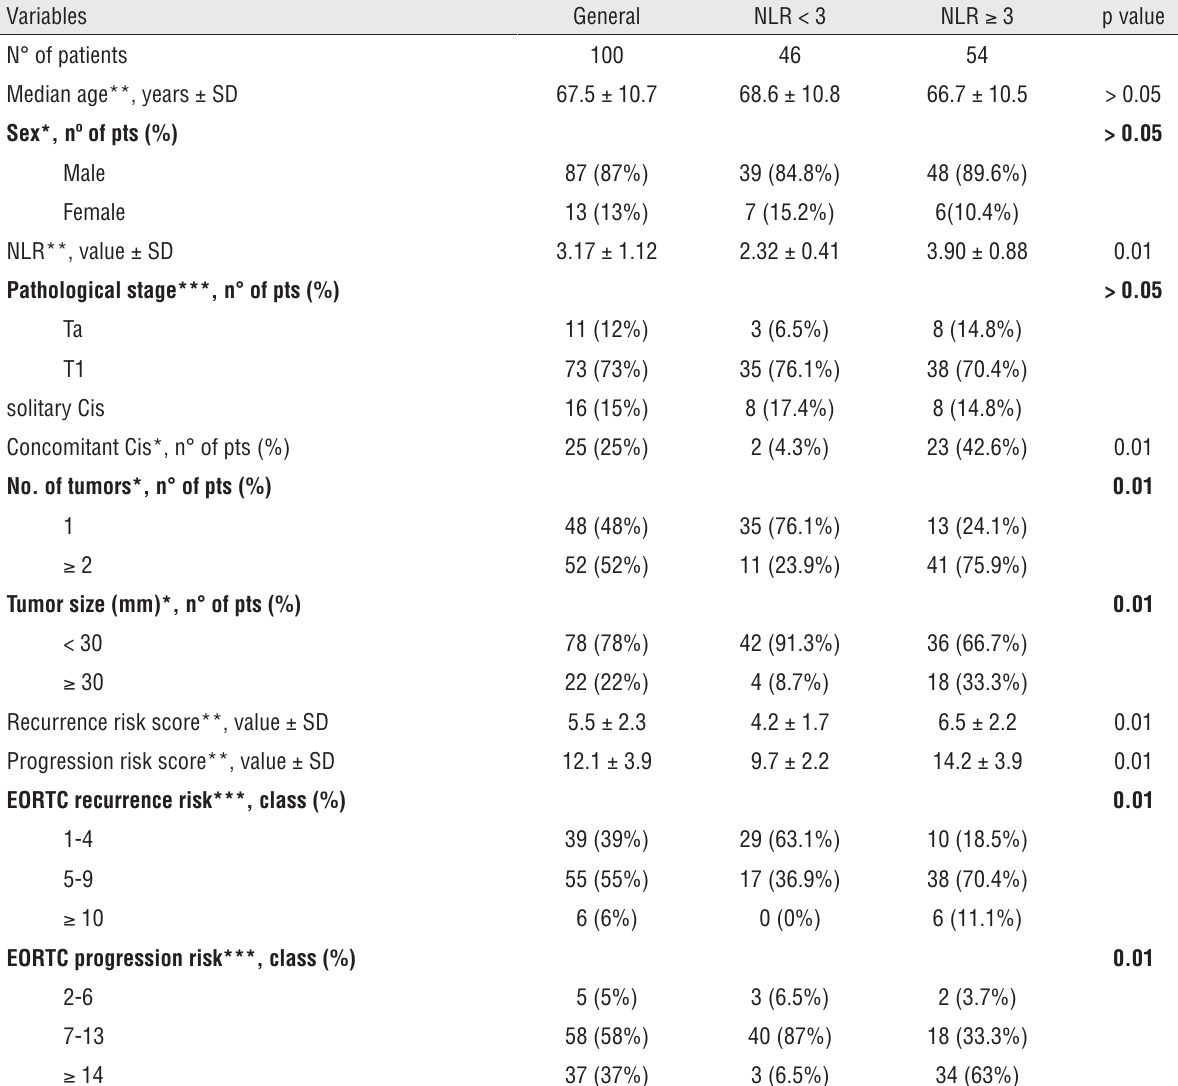
Table 1 - Baseline characteristics based on NLR value.